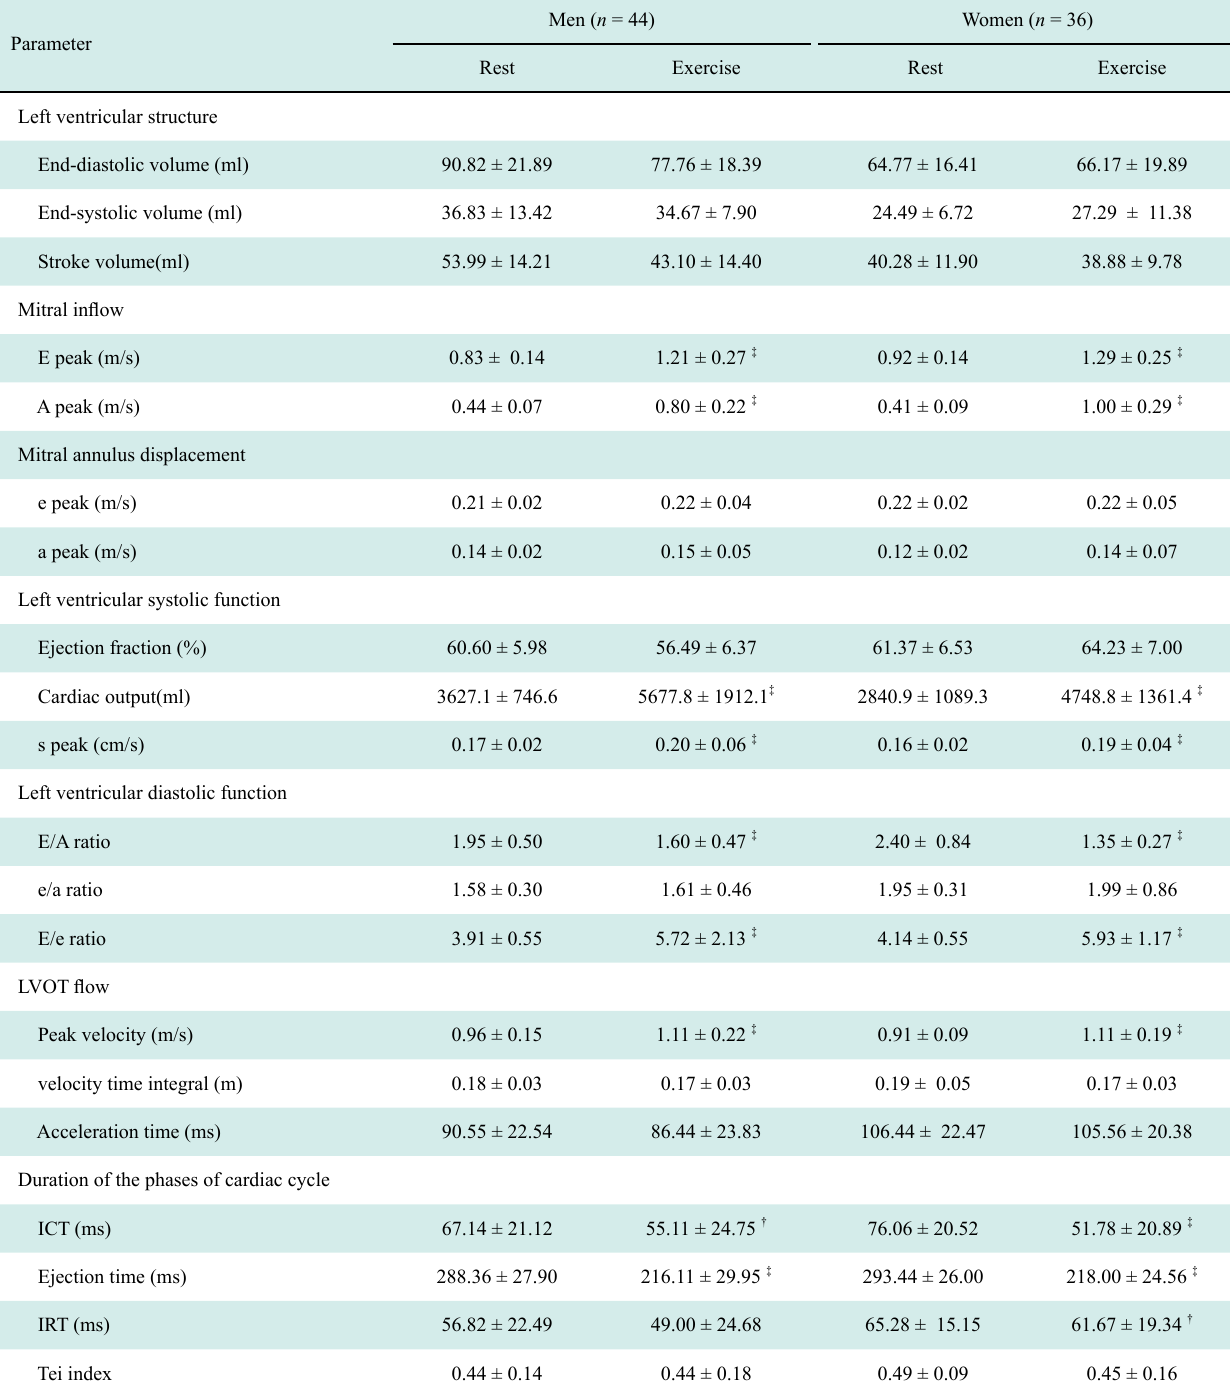
Table 2 Two-dimensional and harmonic Doppler echocardiography findings